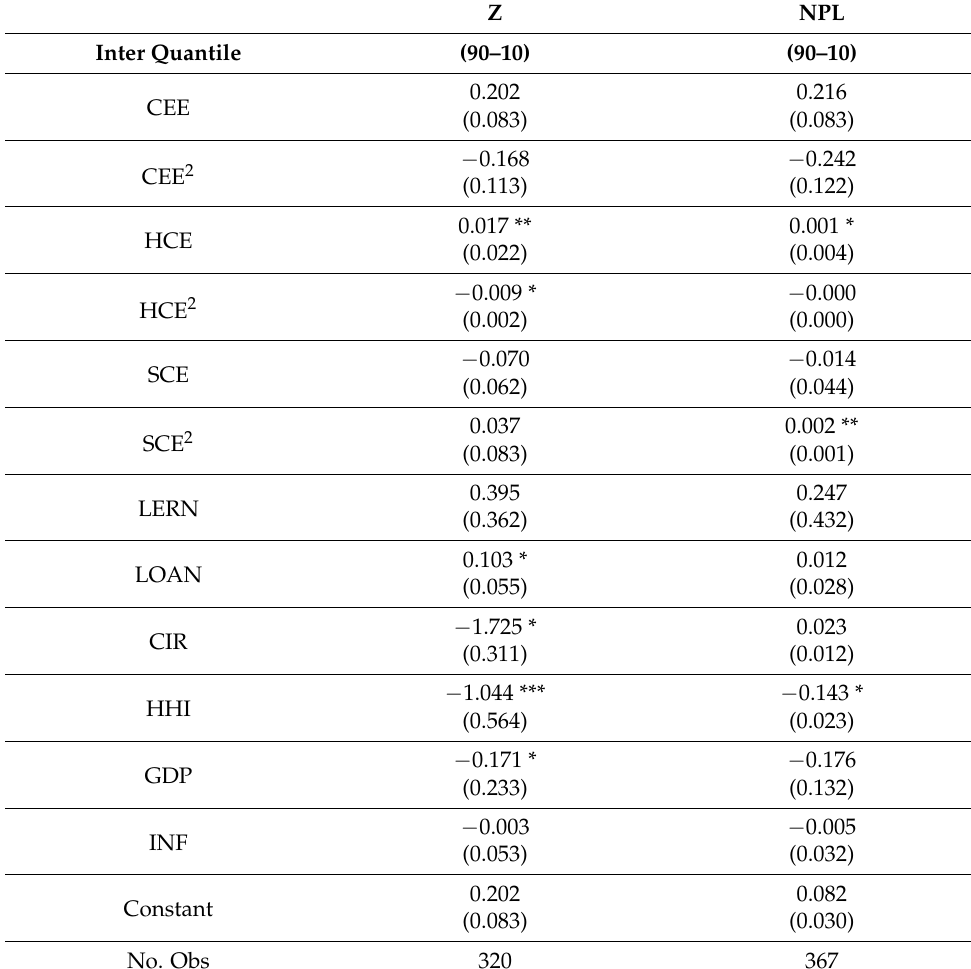
Table 9. The results of inter-quantile regression VAIC’s